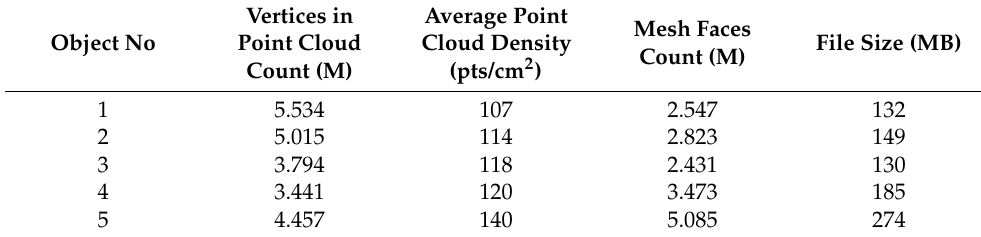
Table 3. Parameters of point clouds and generated 3D meshes.